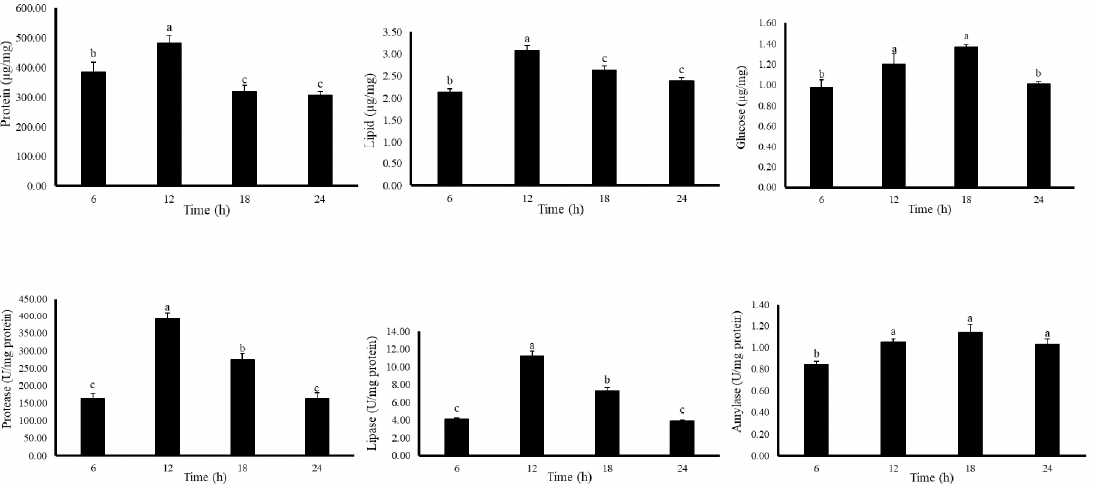
Figure 6. Twenty-four hour changes in activity of body composition and digestive enzymes of G. columna in commercial R1 coral food. Each value represents ±SD ( n = 3). The Latin alphabet represents significant differences ( p < 0.05).